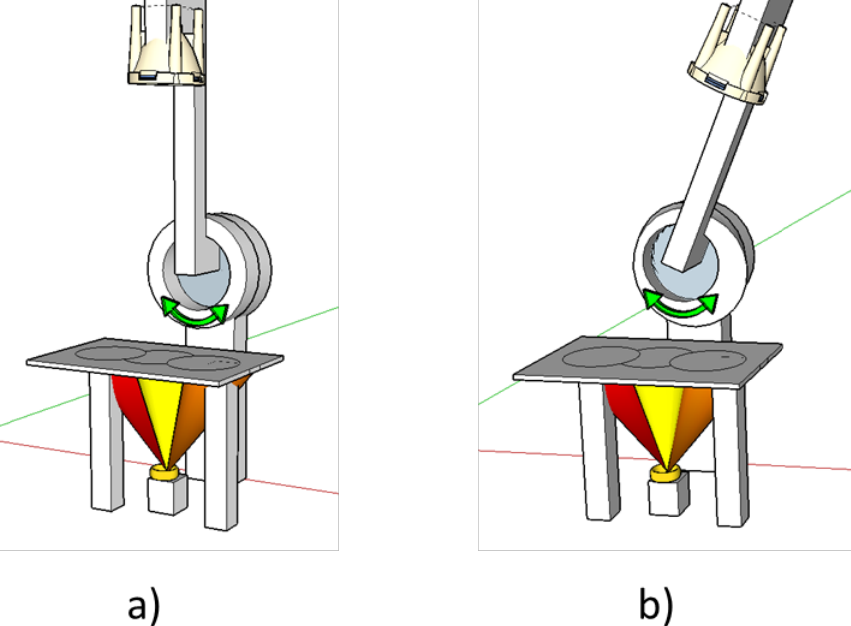
Figure 16. Setup used to characterize the holographic lenses at different angles: ( a ) normal incidence, ( b ) angular incidence. Note: figure is not drawn to scale.